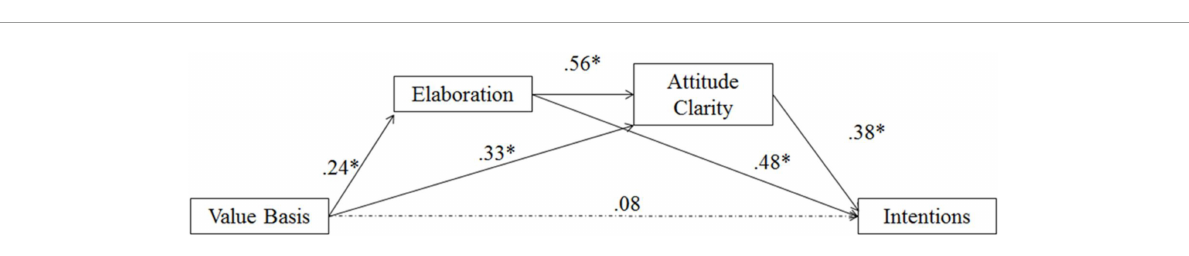
FIGURE5 Multiple mediation of value basis on intentions with perceived elaboration and attitude clarity as mediators in Study 3; ∗ p < 0.05.